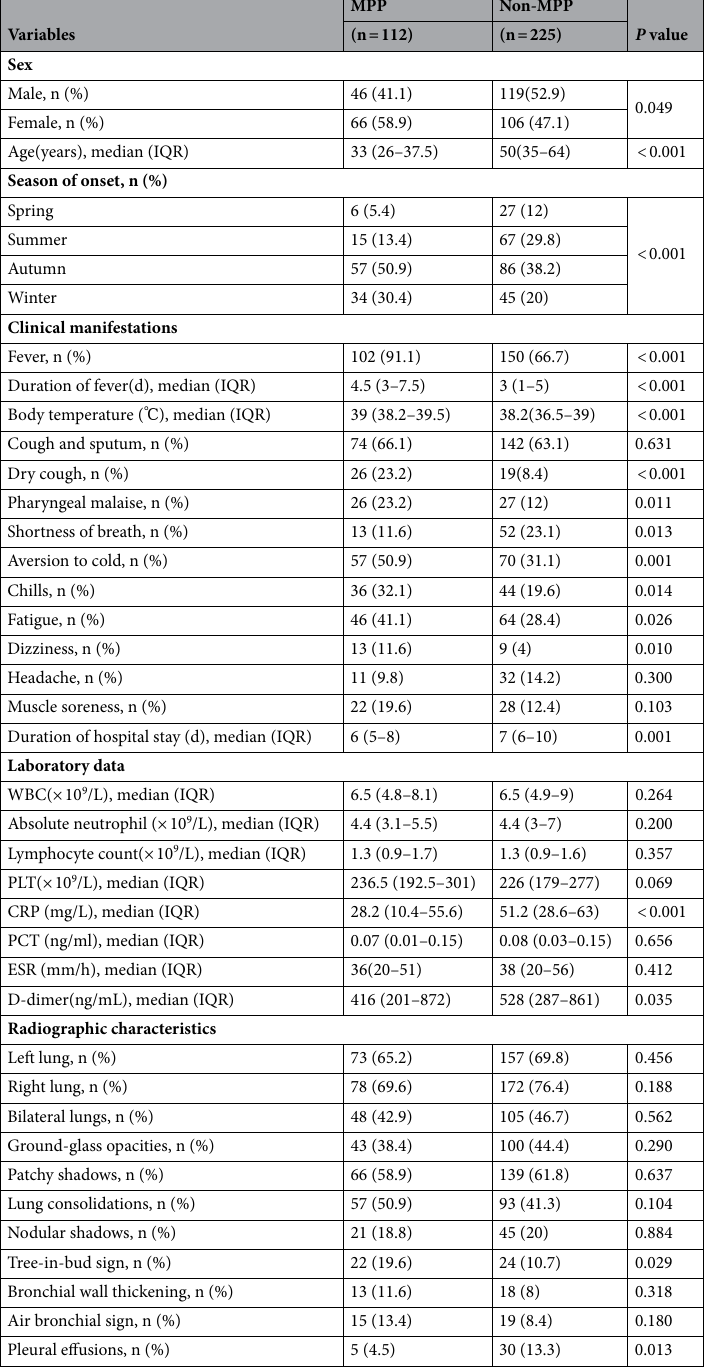
Table 1. Univariate analysis of MPP in adults. WBC white blood cell count, PLT platelet count, CRP C-reactive protein, PCT procalcitonin, ESR erythrocyte sedimentation